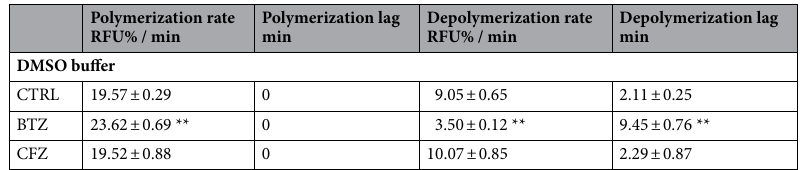
Table 1. Tubulin polymerization and depolymerization rate and lag. ** p < 0.01 versus CTRL and